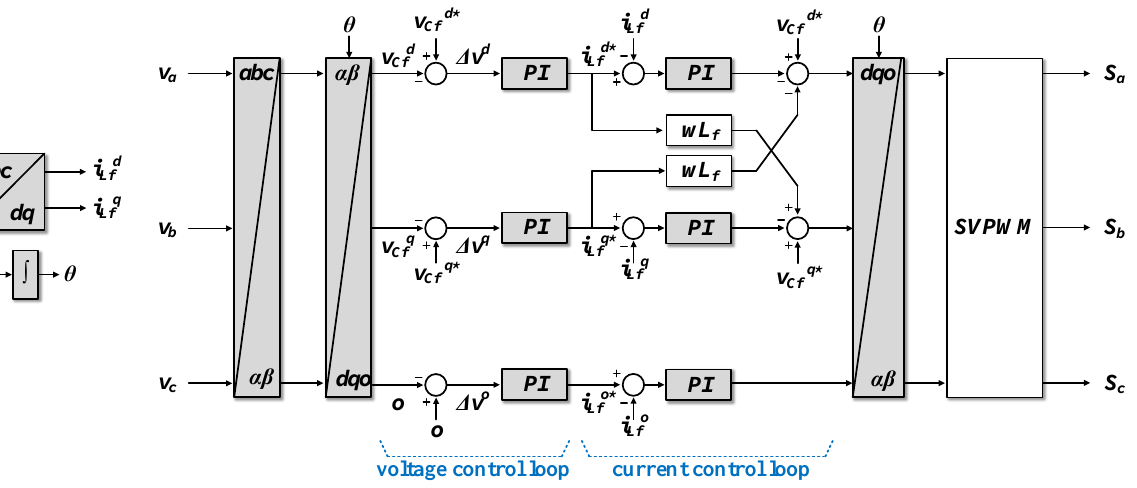
Figure 2. Block diagram of 3-phase 3-wire CVCF inverter using dq0 control.